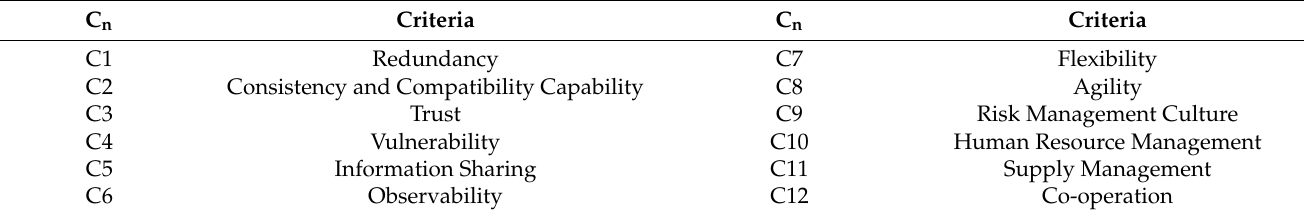
Table 6. Confirmed criteria.